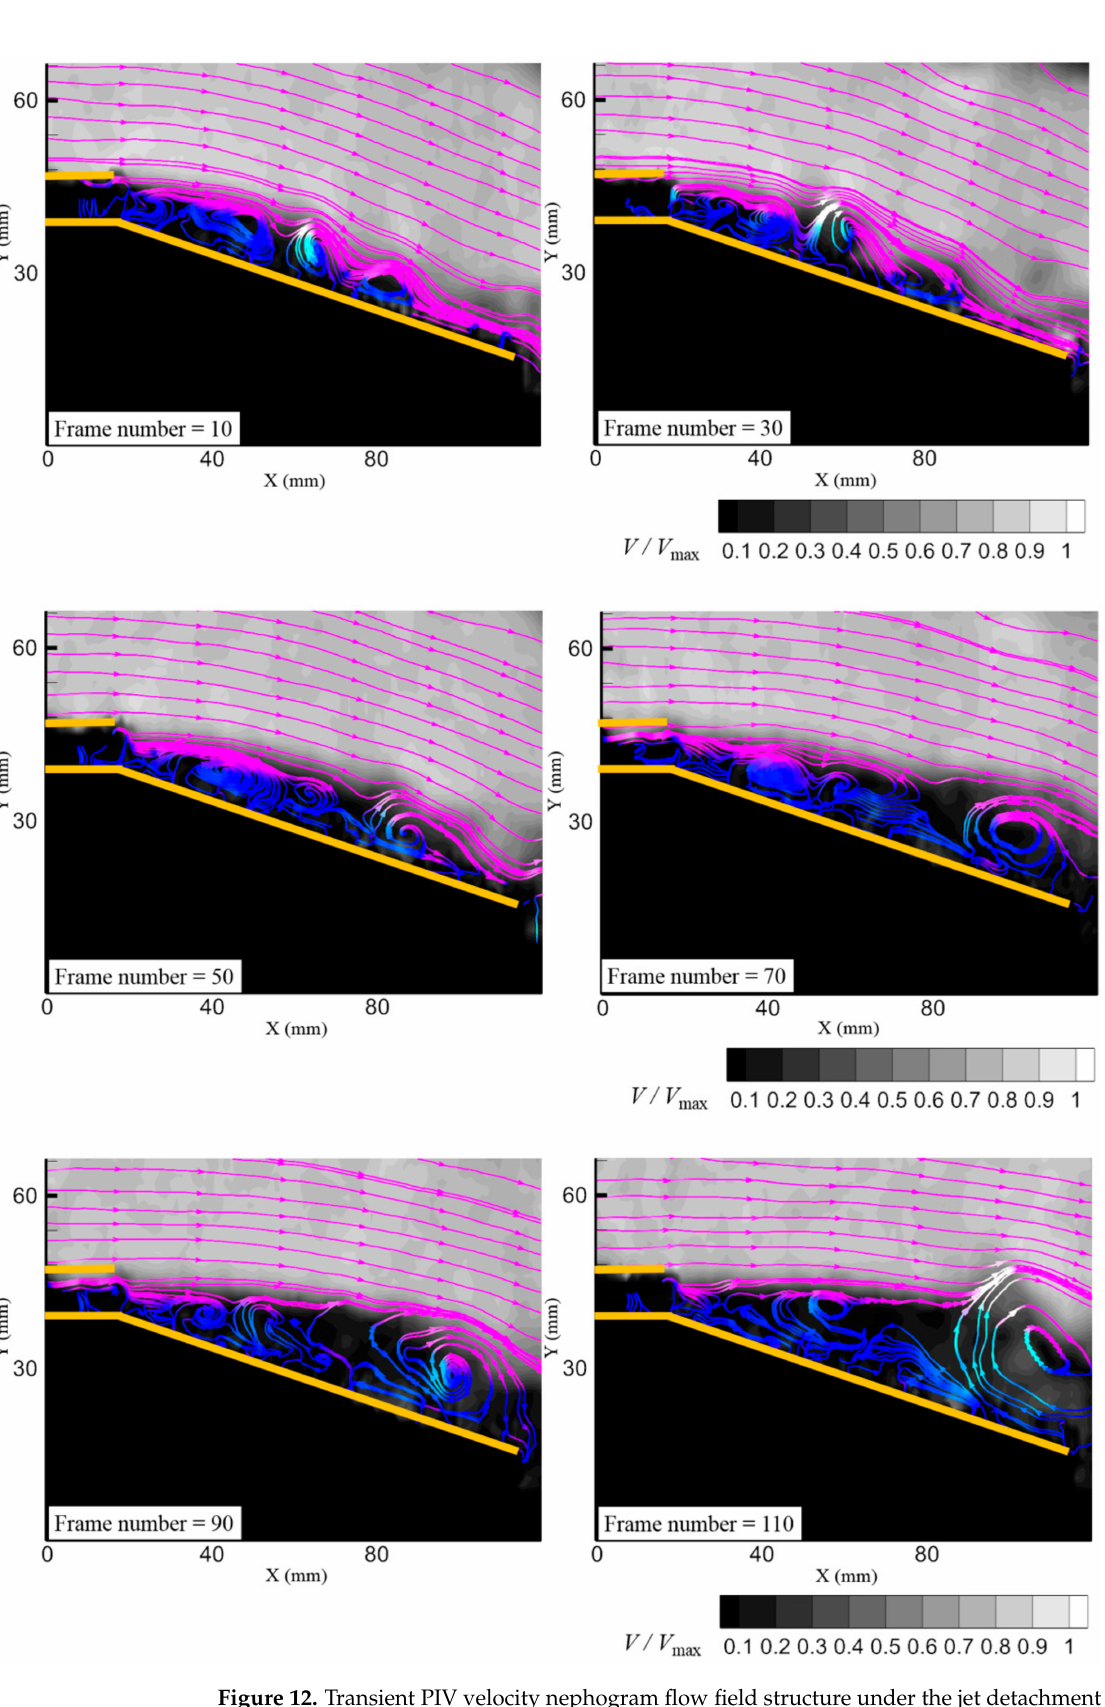
Figure 12. Transient PIV velocity nephogram flow field structure under the jet detachment condition (velocity streamline using RBG